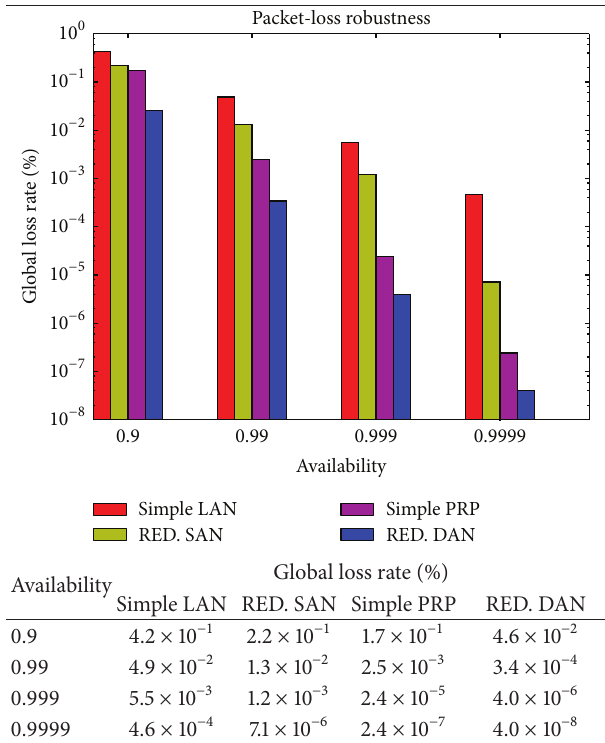
Table 1: Comparison of the packet-loss robustness in different